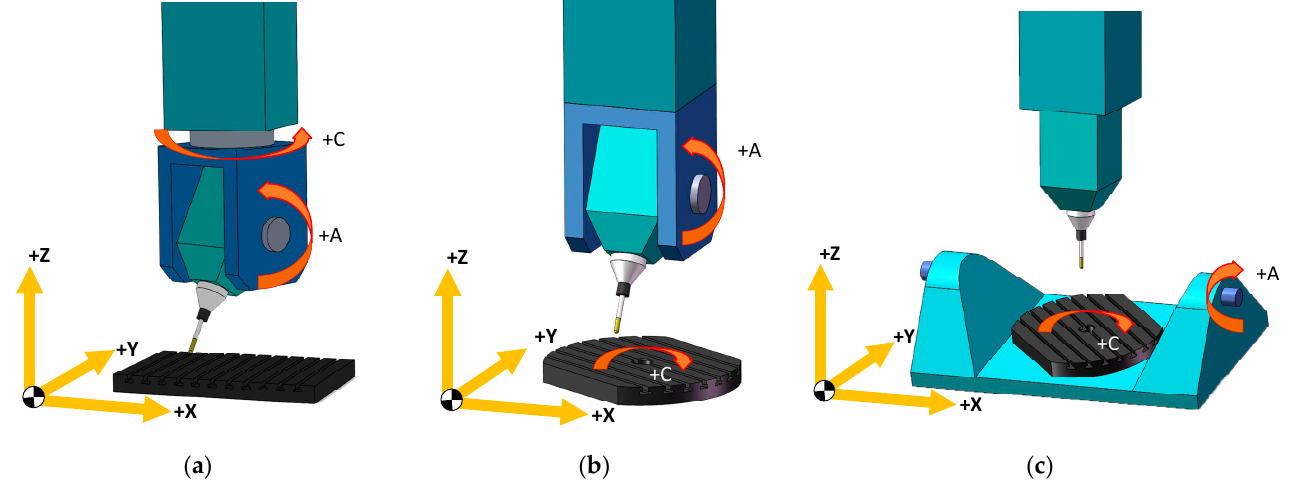
Figure 1. Common structure layouts of machine tools with orthogonal rotary axes. ( a ) Dual-head style, ( b ) single-head and single-turntable style, ( c ) dual-turntable style.